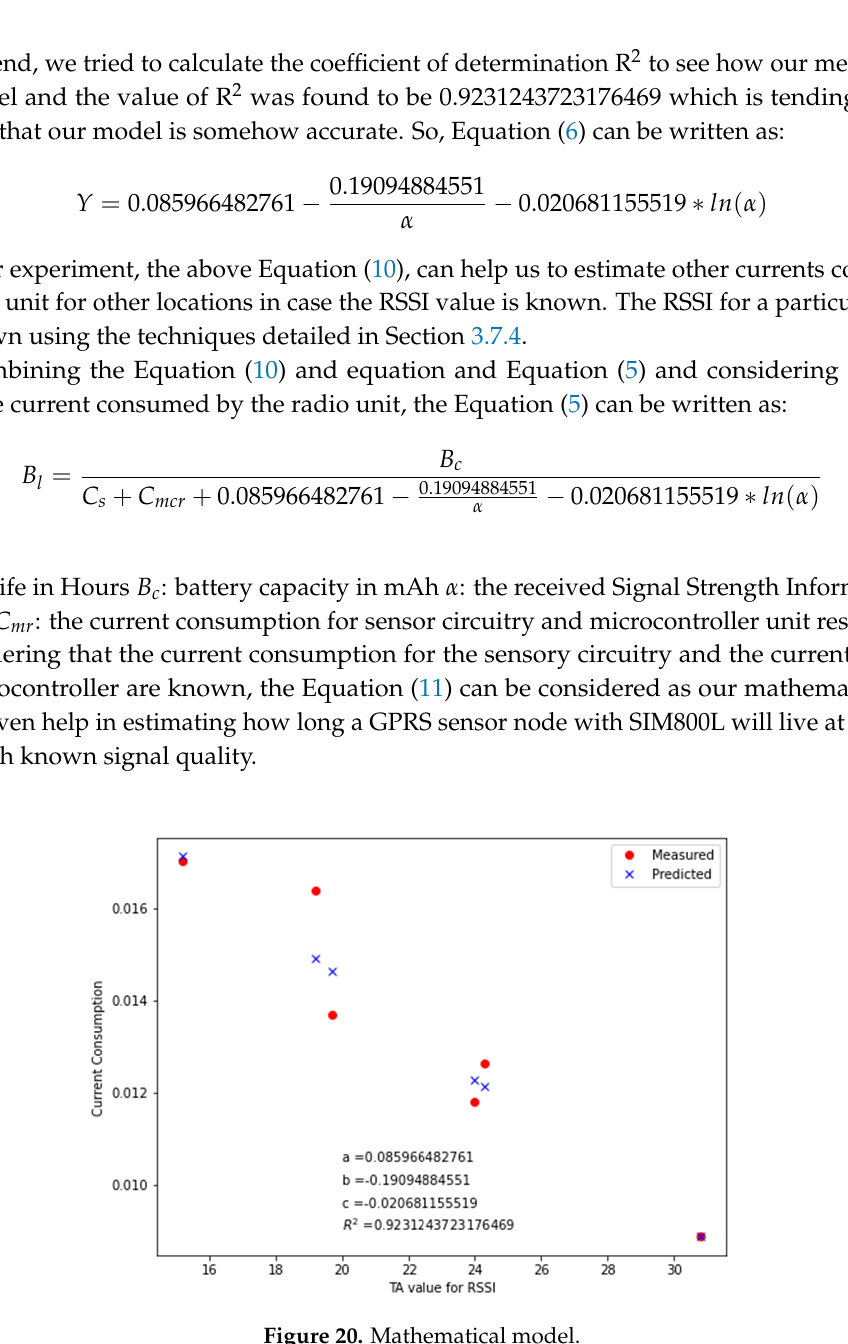
Figure 20. Mathematical